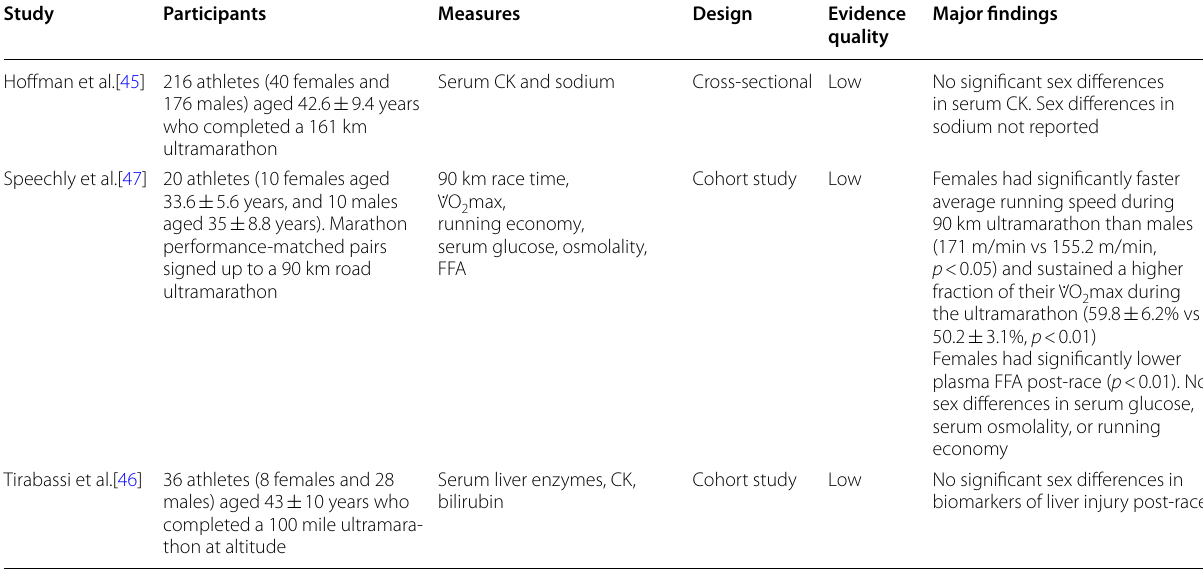
CK, creatine kinase; V ̇ O 2 max, maximal oxygen uptake; and FFA, free fatty acids